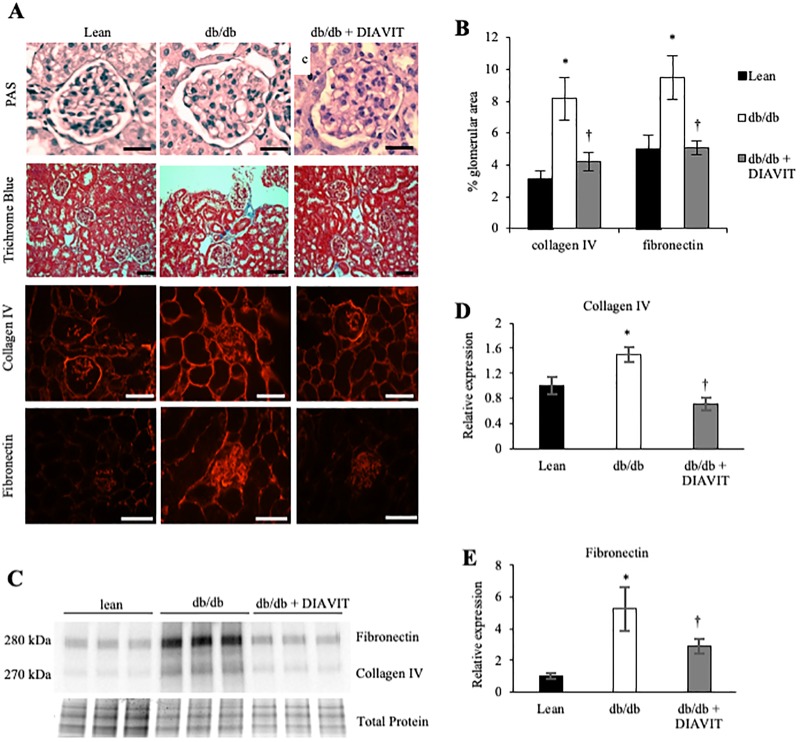
Diabetic db/db mice develop glomerular fibrosis, which is prevented in DIAVIT treated db/db mice.A) Periodic Acid Schiff (PAS) staining indicated structural abnormalities in db/db glomeruli, including mesangial matrix expansion and the presence of vacuoles (scale bar 40 μm). These appeared to be less frequent in DIAVIT-treated db/db glomeruli. Trichrome blue staining showed an increase in fibrosis (blue collagen staining) in the db/db kidney cortex, which was lower in the DIAVIT-treated db/db kidneys (scale bar 40 μm). More specifically, immunofluorescence for collagen IV and fibronectin showed an increase in glomerular fibrosis in db/db mice, compared to lean controls, which was prevented by DIAVIT treatment of the diabetic mice (quantified in B; *p<0.05 lean vs db/db; †p<0.05 db/db vs db/db + DIAVIT; n = 4 mice; 15–20 glomeruli per mouse; One-way ANOVA with Bonferroni post-hoc test for comparison between pairs; scale bar is 40 μm). C) Western blotting of protein from the kidney cortex confirms an increase in the protein expression of collagen IV and fibronectin in db/db mice, which is prevented with DIAVIT treatment. Analysis of the Western blots is summarised in D and E (*p<0.05 lean vs db/db; †p<0.05 db/db vs db/db + DIAVIT; n = 3–4 mice; One-way ANOVA with Bonferroni post-hoc test for comparison between pairs).